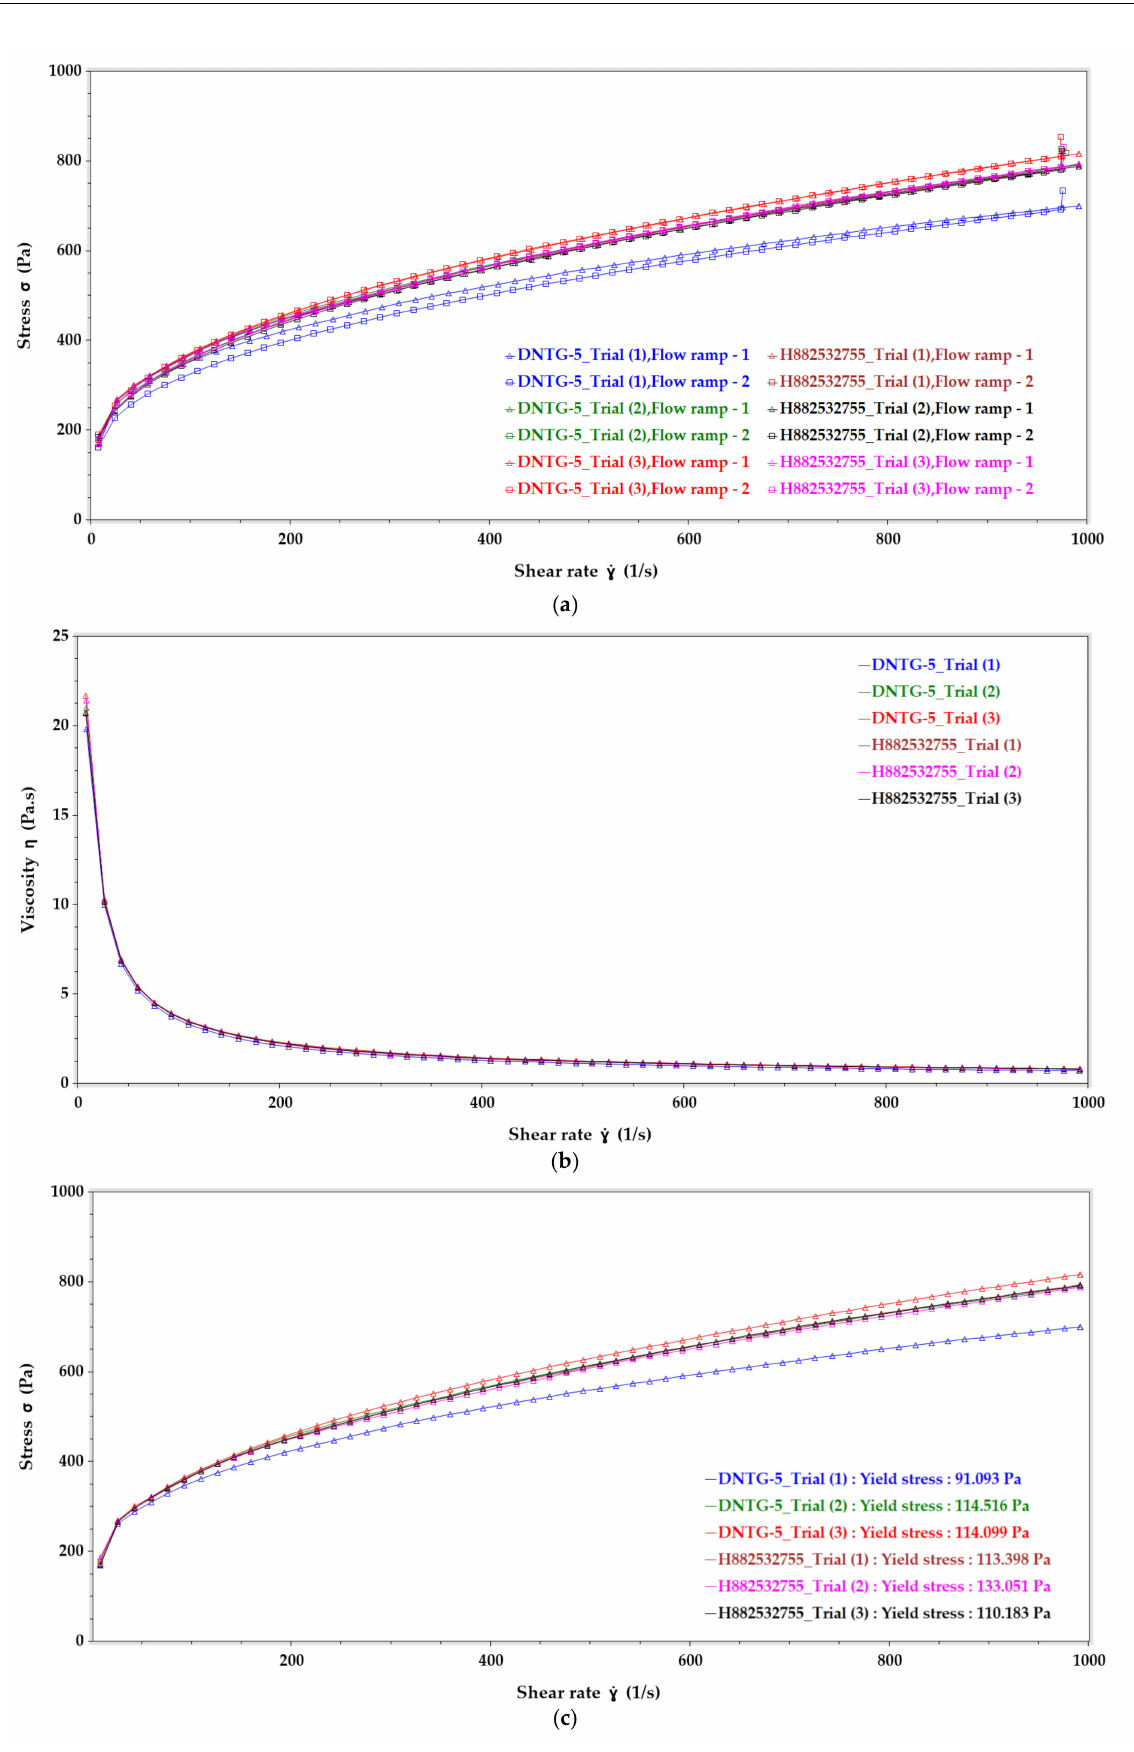
Figure 5. Rheological data comparison: ( a ) Flow curve (upward and downward curve), ( b ) viscosity (low to high shear rate) and ( c ) yield stress (Herschel–Bulkley model) between DNTG-5 and H882532755 ( n =